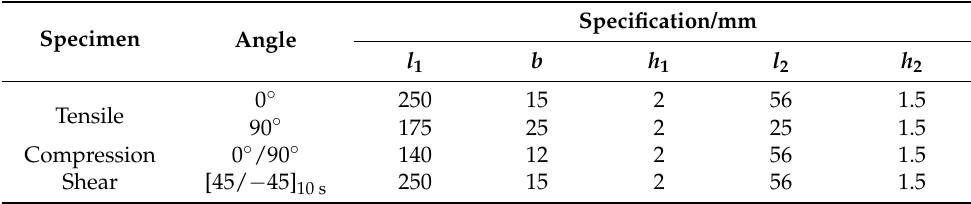
Table 2. Specimen specification.